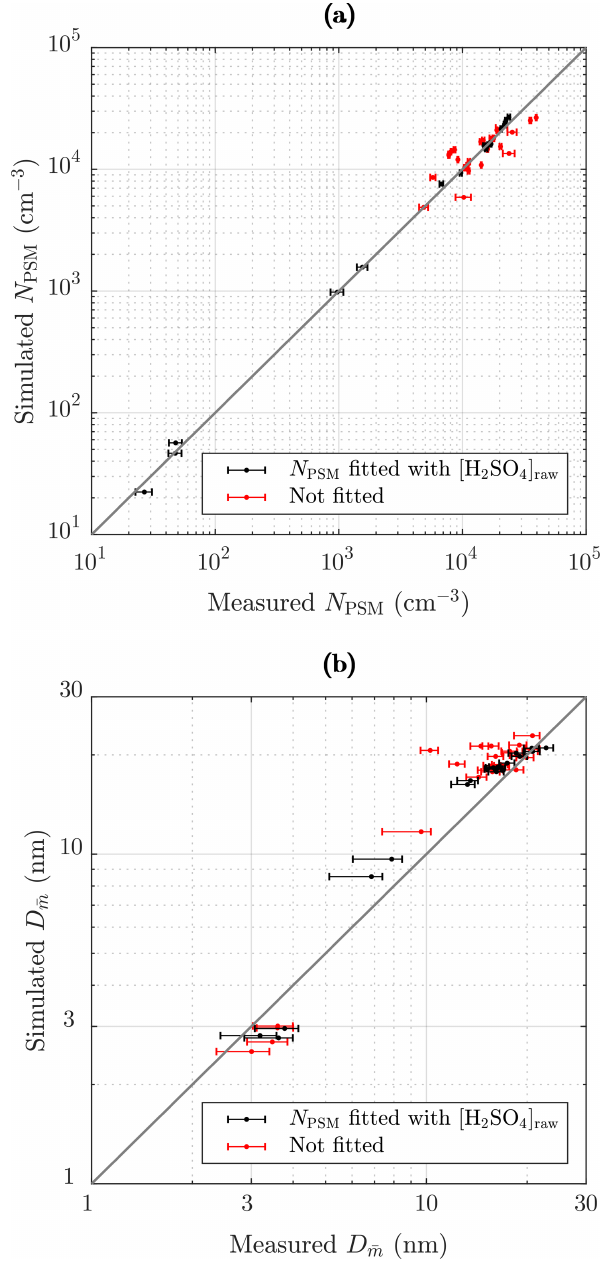
Figure 13. Comparison of the simulated and the measured (a) num- ber concentrations of the particles larger than ∼ 1.3nm and (b) the diameters with the average mass after the ejector diluter. The black dots represent the cases for which N PSM and D m were obtained by fitting the value of [ H 2 SO 4 ] raw . The red dots represent the cases of the measurement sets 2–4 in which the values of [ H 2 SO 4 ] raw origi- nated from an another case of the measurement set having the same T sa value. The error bars in (a) represent the standard uncertainties of the measured concentrations, and the error bars in (b) represent the uncertainties associated with both the systematic and random effects in the measurements (see the Supplement).